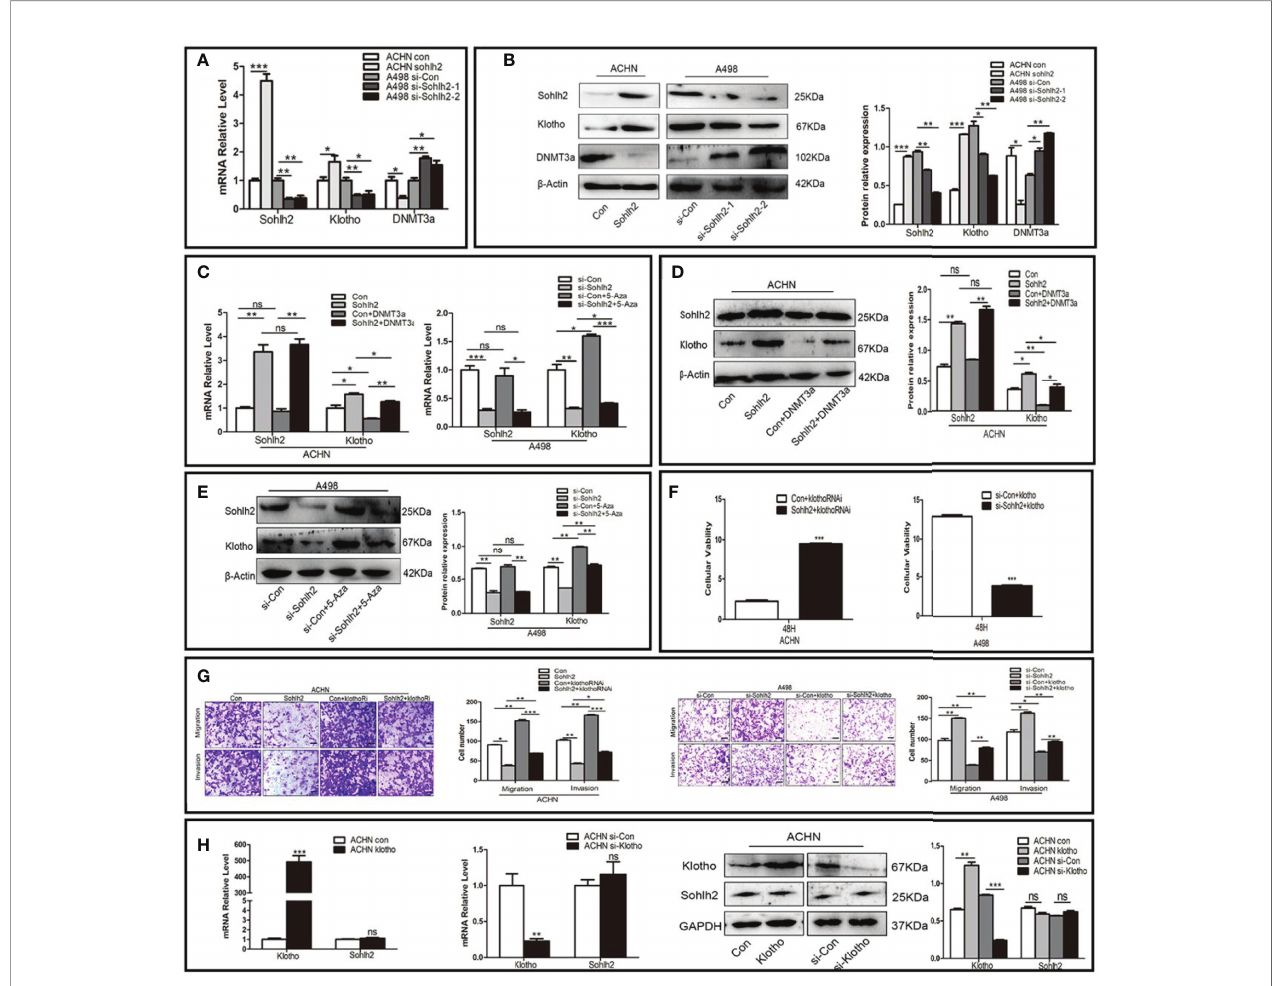
FIGURE 5 | Sohlh2 suppressed RCC through DNMT3a and Klotho. (A, B) The qPCR and Western blotting results of the effect of Sohlh2 on Klotho and DNMT3a expression level in RCC cell lines. (C – E) The qPCR and Western blotting results of the effects of DNMT3a on Sohlh2 and Klotho expression level in RCC cell lines by overexpression of DNMT3a and adding DNMT3a inhibitor 5-Aza. (F) The CCK-8 results of Klotho on the effects of Sohlh2 on the proliferation of RCC cell lines. (G) The role of Klotho on the effects of Sohlh2 on the migration and invasion of RCC cell lines by transwell migration and matrigel invasion assay. (H) The qPCR and Western blotting results of the role of Klotho on the Sohlh2 expression level. RCC, renal cell carcinoma; CCK-8, Cell Counting Kit-8. NS, no signi fi cance. (*P < 0.05; **P < 0.001; ***P <